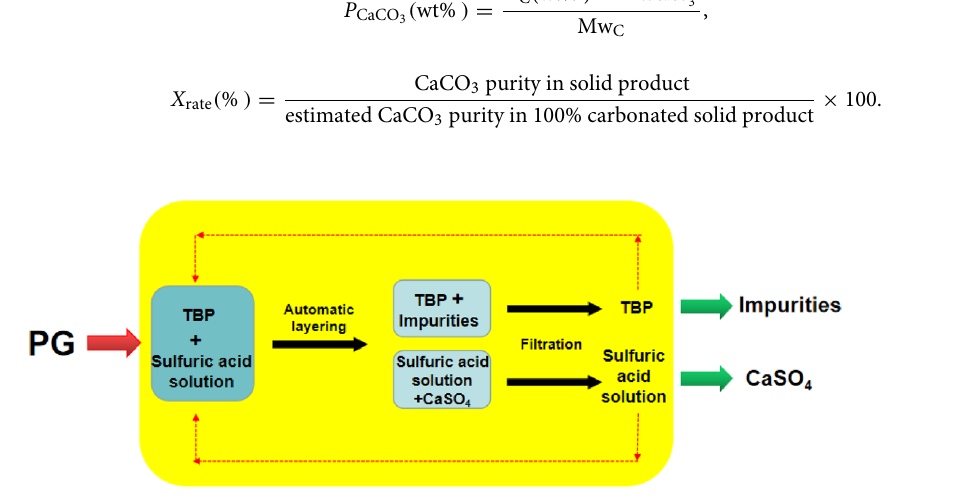
Figure 1. Schematic diagram of this PG purification